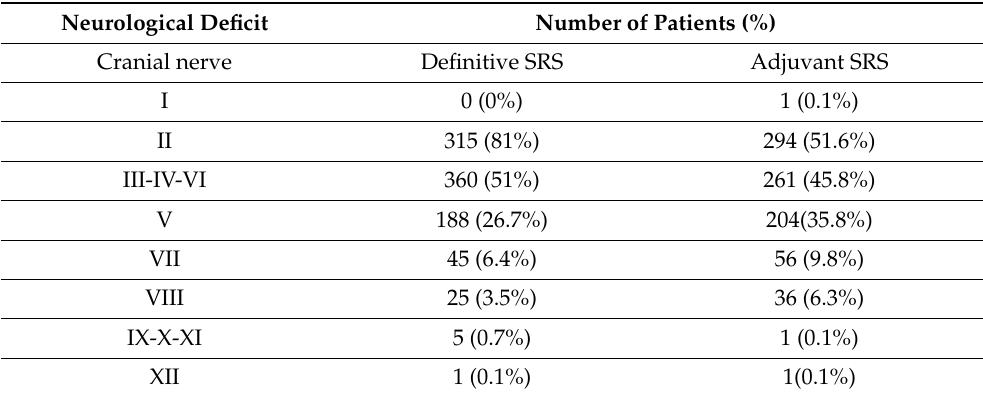
Table 2. Cranial nerve deficits in 1222 patients undergoing SRS for CSMs